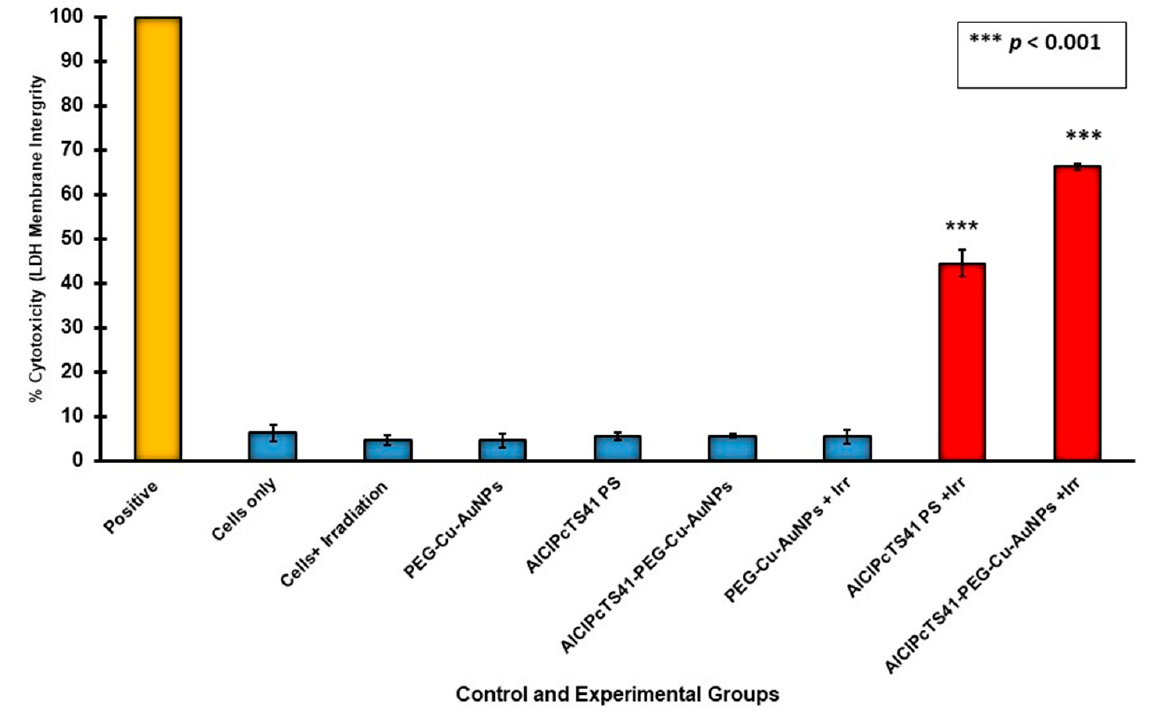
Figure 12. LDH assay of cells + irradiation alone, free AlClPcTS41, AlClPcTS41-PEG-CuAuNPs, and PEG-CuAuNPs in the dark, and AlClPcTS41 + irradiation, PEG-CuAuNPs + irradiation, and AlClPcTS41-PEG-CuAuNPs + irradiation in Caco-2 cells. (*** p < 0.001), *** shows statistical signifi- cance compared to cells only.